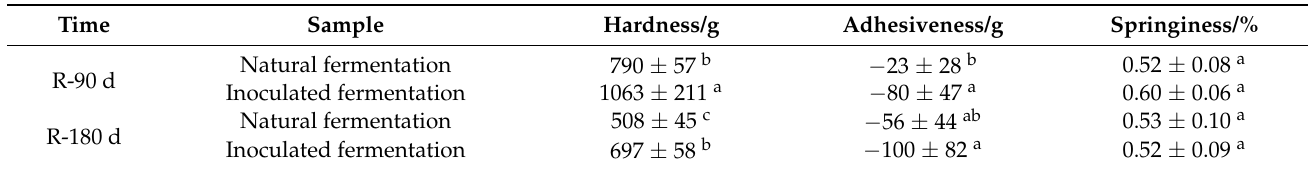
Table 5. Texture profile analysis of natural and inoculated fermented sufu.